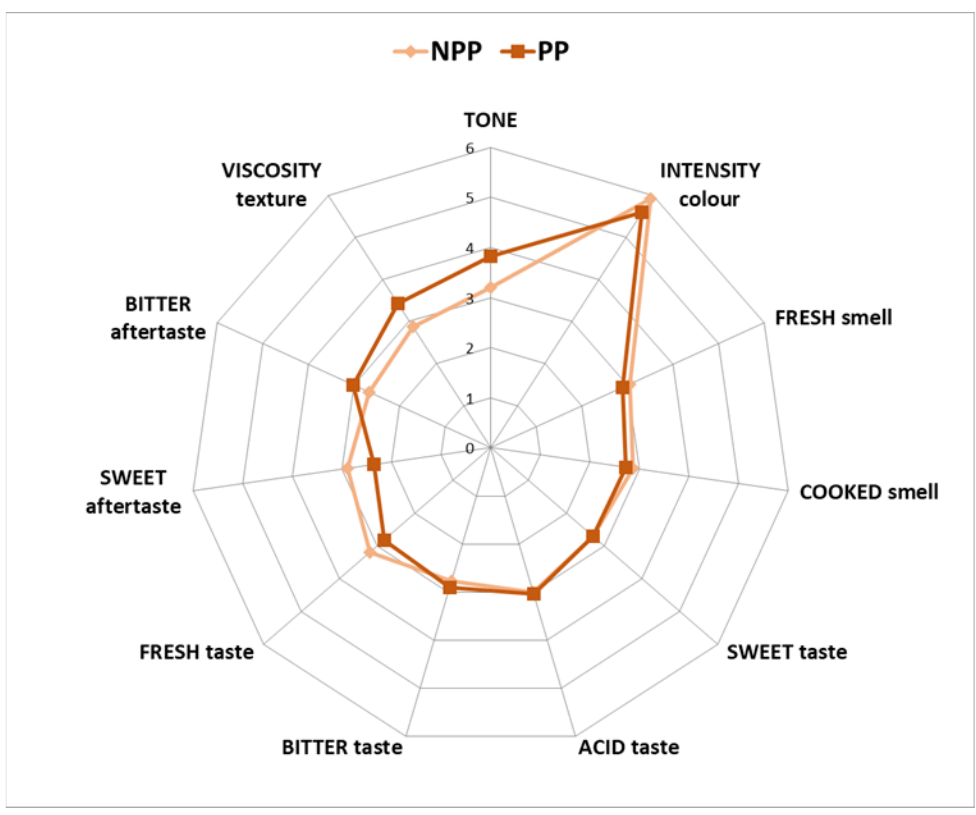
Figure 3. Radial chart about the sensorial attributes of non-pasteurized pulp (NPP) and pasteurized pulp (PP) evaluated by sensory panel.